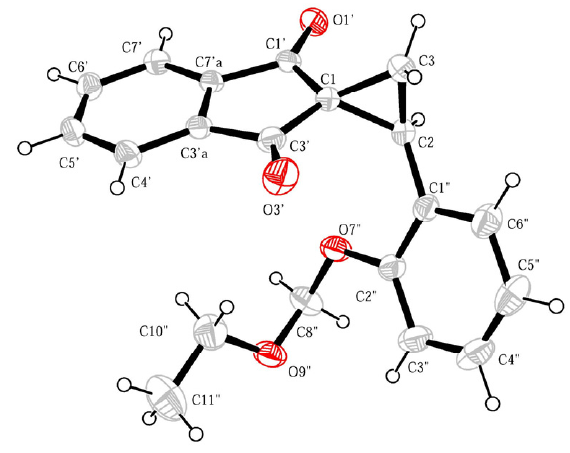
Figure 1. Molecular structure (ORTEP-3) from single-crystal X-ray study of 4 .